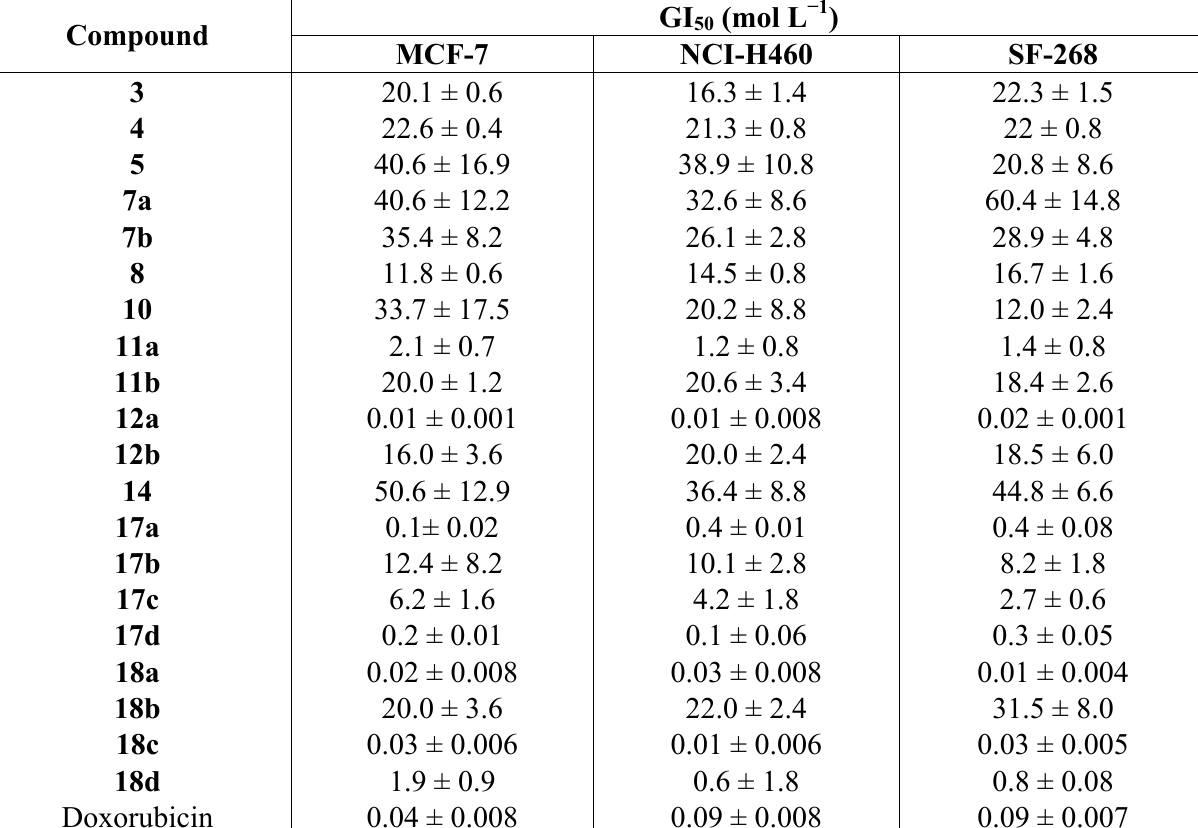
Table 1. Effect of the newly synthesized compounds on the growth of three human tumor cell